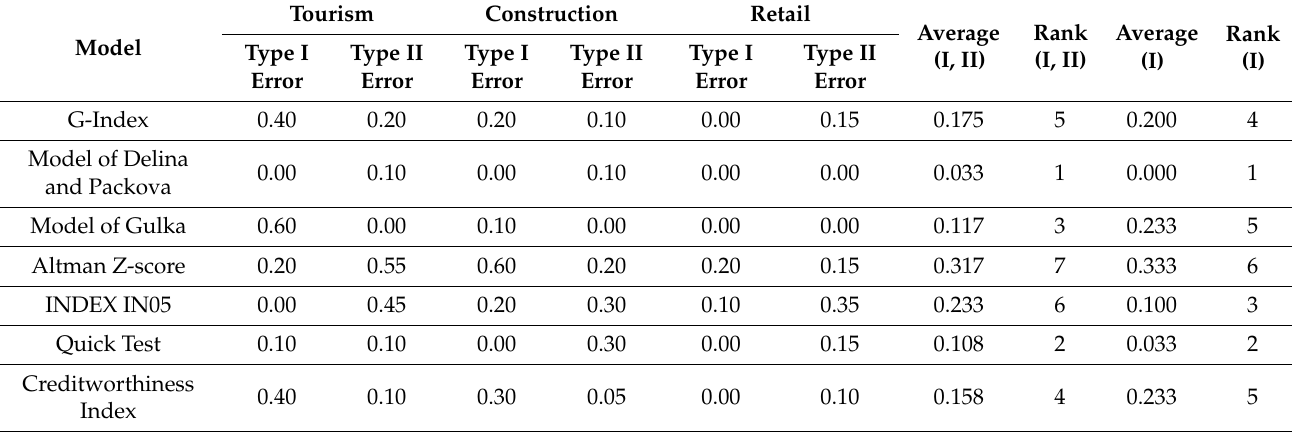
Table 10. Error rate assessment of default prediction models in tourism, construction and retail sector in 2018. Tourism Construction Retail Model